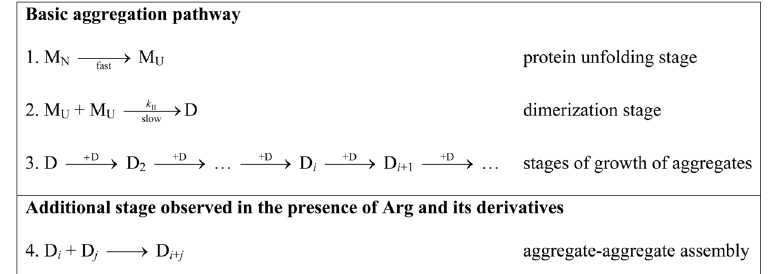
Figure 8. Aggregation pathway for BSA aggregation at 70 °C. M N and M U are the native and unfolded forms of monomeric BSA, respectively. D is a dimer, which is a product of slow dimerization of M U . D 2 , D i , D i + 1 , D j and D i + j are aggregates formed by dimers D (subscript is a number of